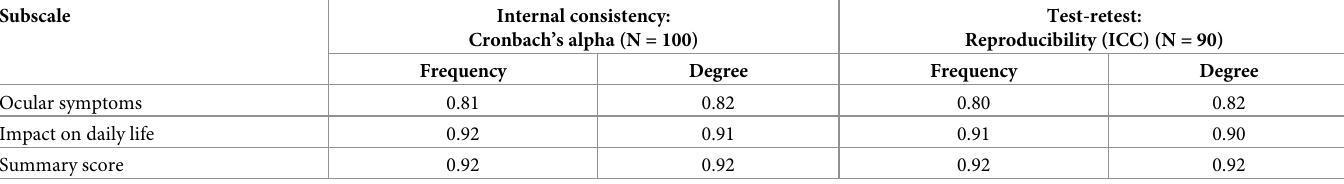
Table 4. Internal consistency and reproducibility of the DEQS-Th.